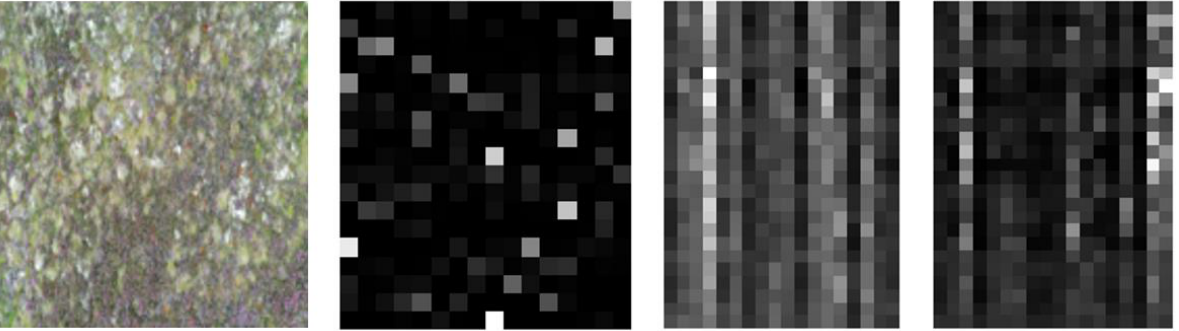
Figure 8. Sample Image from PB4 and its predicted features for base-learners with VGG16, Resnet34 and MobilenetV2 respectively.